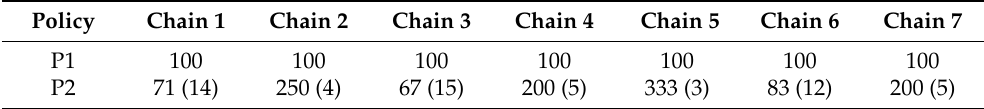
Figure 4. Red chain is a fully ordered set, and the yellow chain is a partially ordered set. Each chain is independent. (For example, it is not possible to compare the order of confirmed patients on the same day in the yellow chain.) Table 2. Compensation equally distributed to people in each chain in the infection network as shown in Figure 3. The compensation is rounded off to the first decimal place, and the numbers in parentheses are the number of people in each